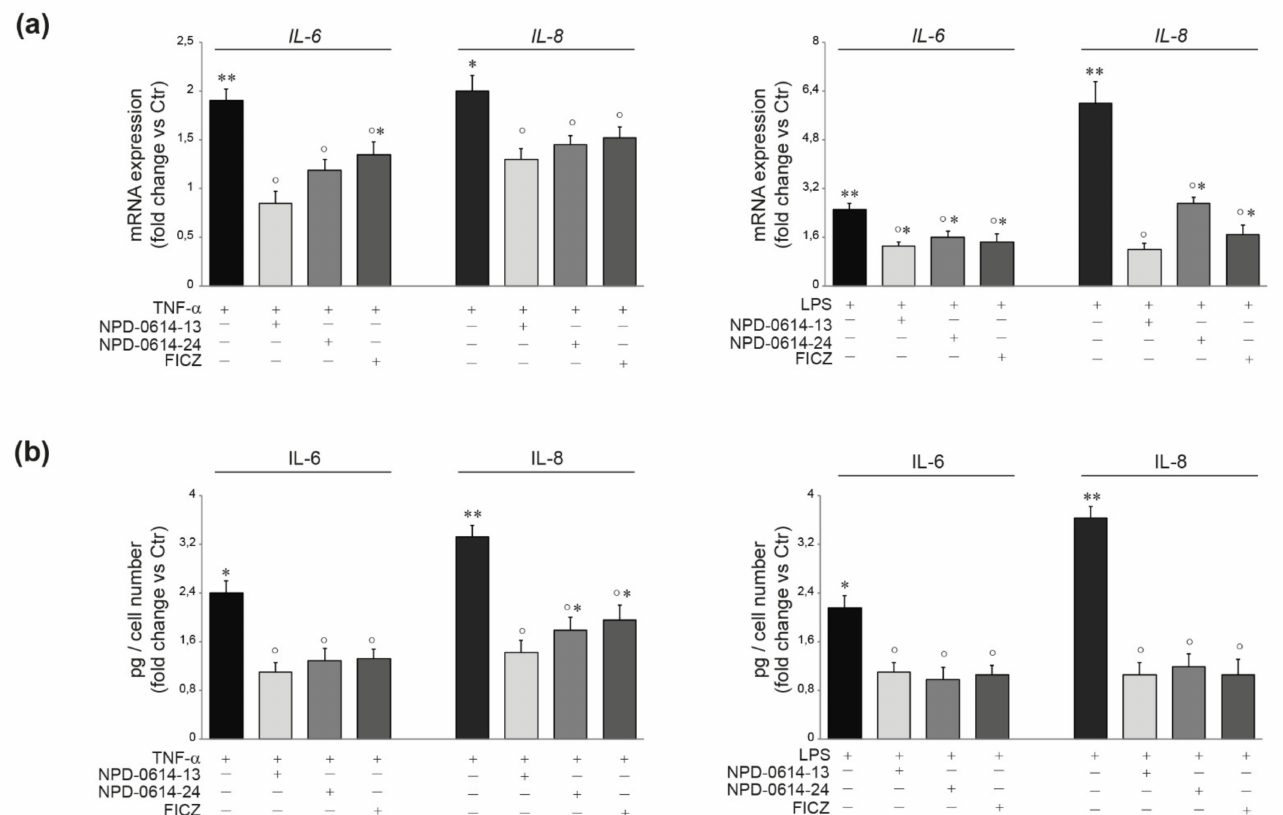
Figure 4. NPD-0614-13 and NPD-0614-24 counteracted the inflammatory pathways induced by TNF- α or LPS in NHKs. ( a ) ROS levels in NHKs stimulated with TNF- α (20 ng/mL) or LPS (10 µ g/mL) in the presence or absence of NPD-0614-13, NPD-0614-24 (25 µ M) or FICZ (100 nM) for 30 min. Results are expressed as the fold change respect to untreated control cells (significance vs. untreated control or vs. stimulated cells are marked with * and ◦ , respectively; ** p < 0.01 vs. untreated cells; ◦◦ p < 0.01 vs. TNF- α or LPS stimulated cells). ( b ) Western blot analysis and corresponding densitometric analysis of phospho-p38 and phospho-c-Jun protein expression in NHKs treated as above for 30 min. β -tubulin and GAPDH were used as endogenous loading control. Results are expressed as the fold change respect to untreated control cells (* p < 0.05 vs. untreated cells; ◦ p < 0.05 vs. TNF- α or LPS stimulated cells). ( c ) Western blot analysis and corresponding densitometric analysis of NF- κ B p65 at nucleus (NpNF- κ Bp65) and cytoplasm level (CpNF- κ Bp65) on NHKs stimulated as above for 30 min. GAPDH was used as the loading control. Results are expressed as the fold change respect to untreated control cells (* p < 0.05 vs. untreated cells; ◦ p < 0.05 vs. TNF- α or LPS stimulated cells). ( d ) Representative immunofluorescence images and fluorescence quantitative analysis of NF- κ B p65 localization in NHKs untreated ( A , F ) and stimulated with TNF- α (20 ng/mL) ( B ) and LPS (10 µ g/mL) ( G ), in the presence or absence of NPD-0614-13 (25 µ M) ( C , H ), NPD-0614-24 (25 µ M) ( D , I ) and FICZ (100 nM) ( E , J ) for 30 min. Nuclei were counterstained with DAPI. Bar: 20 µ m. Results are expressed as the number of cells with a nuclear positive staining and are reported as mean value ± SD (%) (* p < 0.05 vs. untreated cells; p < 0.05 vs. TNF- α or LPS stimulated cells).